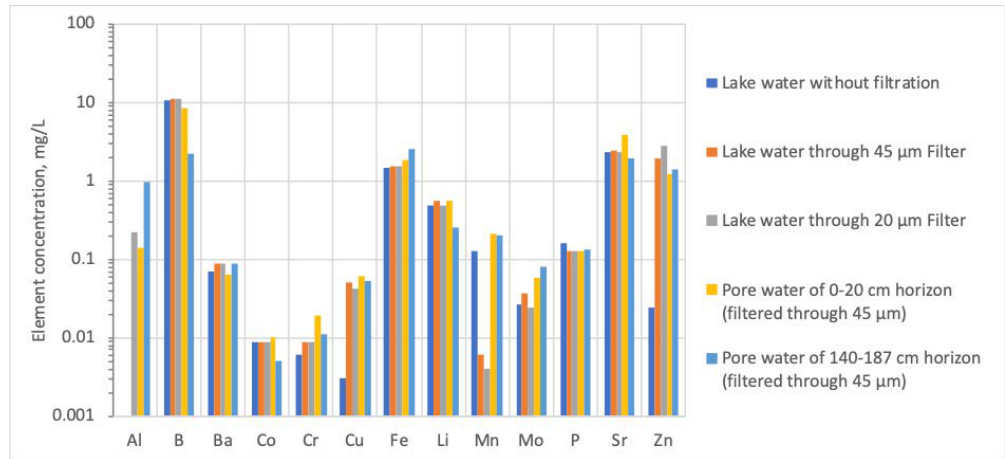
Figure 2. Trace elements composition of lake- and pore-water.